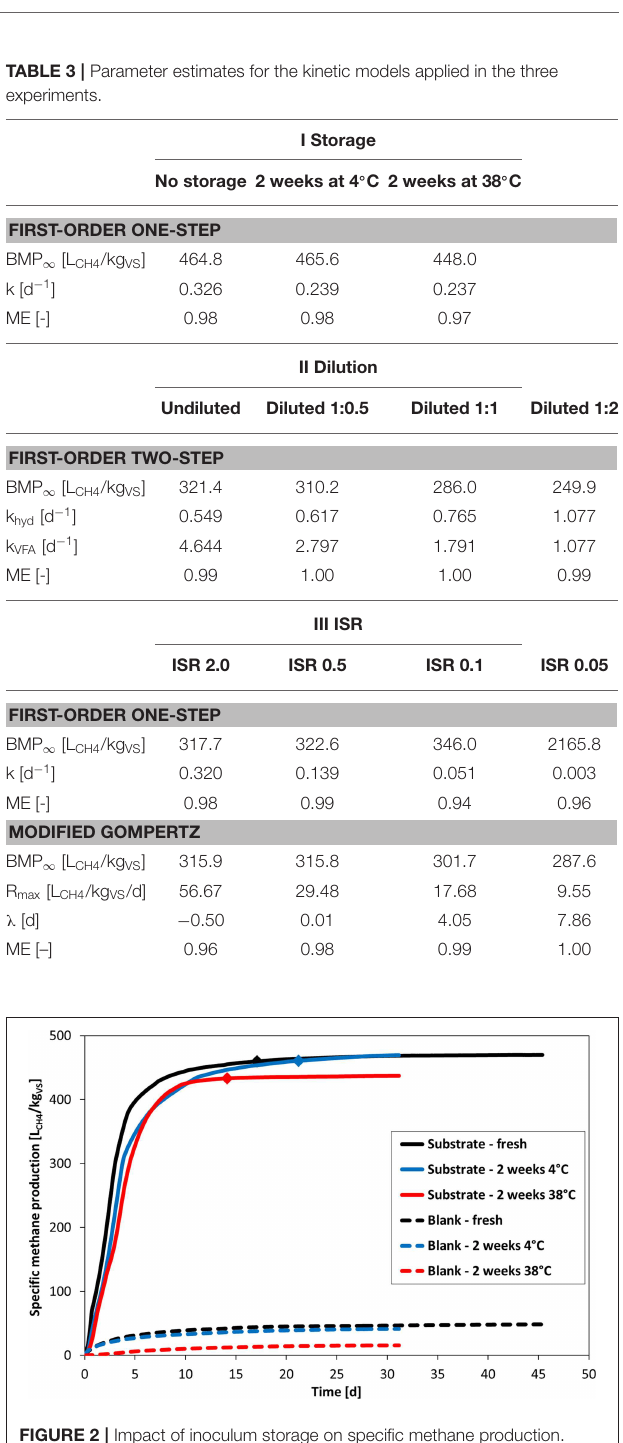
FIGURE 2 | Impact of inoculum storage on specific methane production. Plotted values are the mean of three replicate bottles for each condition. Diamonds indicate the time when the daily gas production was below 1% of cumulative production during 3 consecutive